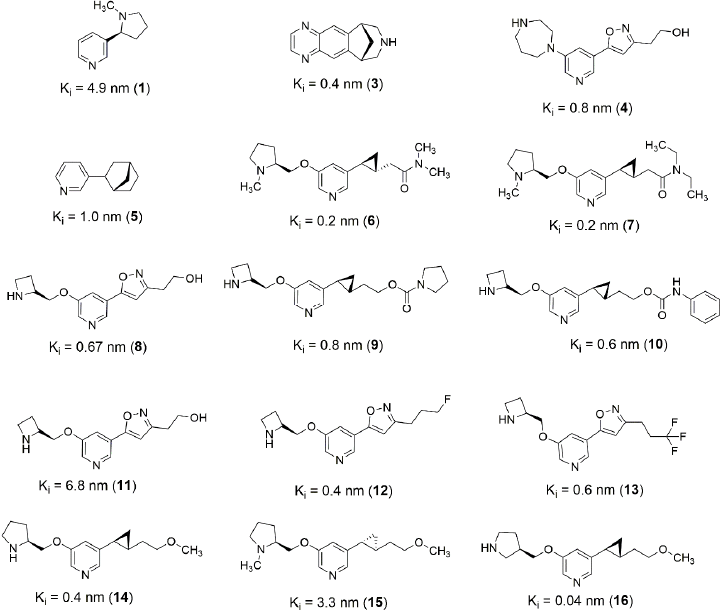
Figure 4. 2D structures of best well ‐ behaved ligands used for ( α 4) 2 ( β 2) 3 receptor pharmacophore mapping.